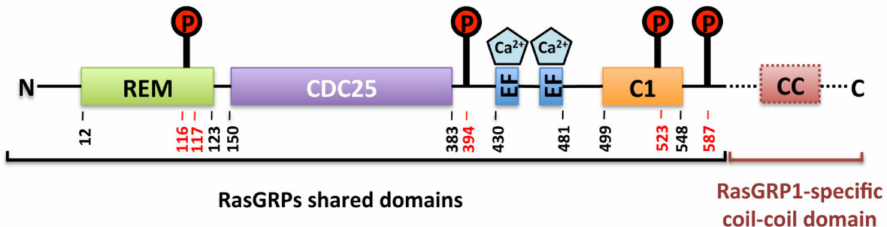
Figure 1. Structural organization of the Ras guanine-nucleotide releasing proteins (RasGRPs) with amino acide sequence annotation for RasGRP2. The protein domains indicated are the Ras exchange motif (REM), catalytic domain (CDC-25), calcium-binding helix(E)-loop-helix(F) hands (EF), diacylglycerol-binding domain (C1) and the RasGRP1 specific C-terminal coil-coil domain (CC). Circled P and red numbers correspond to phosphorylation sites on serine residues involved in RasGRP2 activity